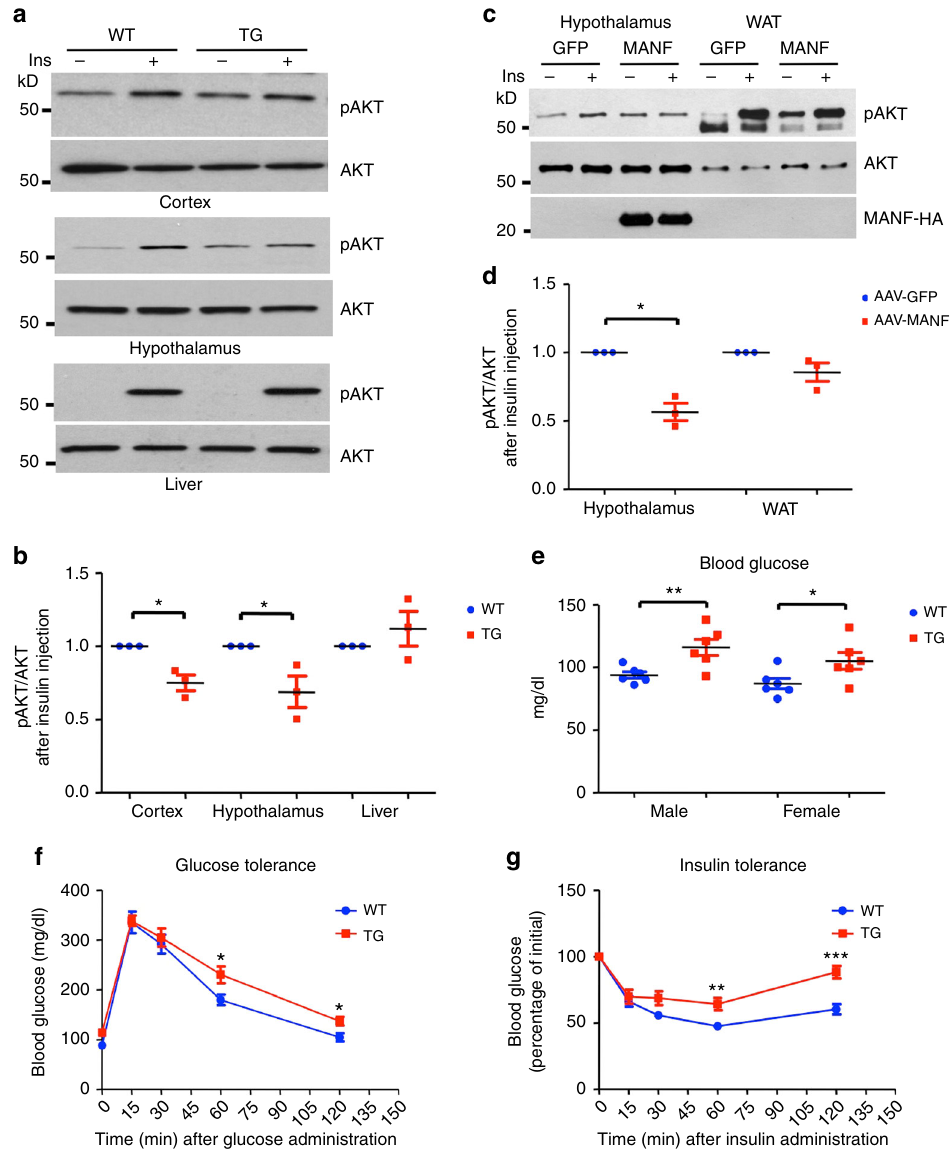
Fig. 6 MANF overexpression leads to insulin resistance. a Representative western blotting images (from three independent experiments) of pAKT levels in wild type (WT) or MANF transgenic (TG) mice injected with either insulin (Ins+) or PBS (Ins − ). b Quanti fi cation of western blotting result in Fig. 6a. Relative pAKT levels of WT and TG mice injected with insulin were calculated using the ratio of pAKT band intensity to AKT band intensity (* P < 0.05, ** P < 0.01, n = 3; 2-tailed student t test, Cortex, t = 4.686, P = 0.0426; Hypothalamus, t = 2.941, P = 0.0494; Liver, t = 0.9982, P = 0.4233). c Representative western blotting images (from three independent experiments) of pAKT levels in WT mice transduced with either AAV-GFP (GFP) or AAV-MANF (MANF) in the hypothalamus, and then injected with either insulin (Ins+) or PBS (Ins − ). d Quanti fi cation of western blotting result in Fig. 6c (* P < 0.05, n = 3; 2-tailed student t test, Hypothalamus, t = 6.905, P = 0.0203; WAT, t = 2.13, P = 0.1669). e Blood glucose levels of 6-week old WT and TG mice were measured (* P < 0.05, ** P < 0.01, n = 6; 2-tailed student t test, Male, t = 3.196, P = 0.0096; Female, t = 2.319, P = 0.0428). f Glucose tolerance of 6-week old WT and TG mice was measured (* P < 0.05, n = 8; 2-tailed student t test, 60-min, t = 2.472, P = 0.0269; 120-min, t = 2.721, P = 0.0166). g Insulin tolerance of 6-week old WT and TG mice was measured (* P < 0.05, n = 6; 2-tailed student t test, 60-min, t = 3.262, P = 0.0085; 120-min, t = 4.677, P = 0.0009). Data are represented as mean ±